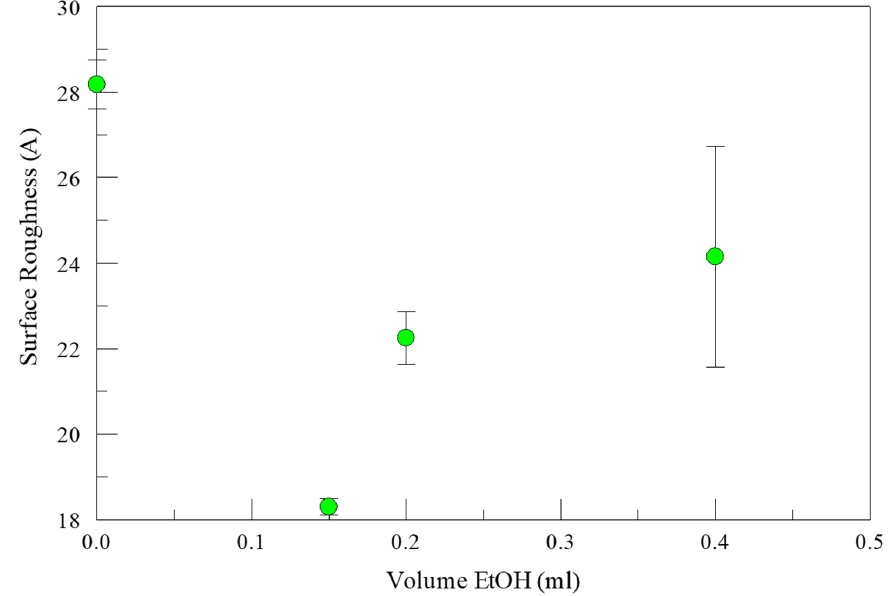
Figure 7. Surface roughness of HKUST-1 SURMOF films exposed to varying amounts of ethanol vapor at 65 °C showing initial surface plasticization and recovery with increasing volumes of solvent. The error bars represent the standard deviation of roughness measurements from at least three distinct areas on the sample surface.